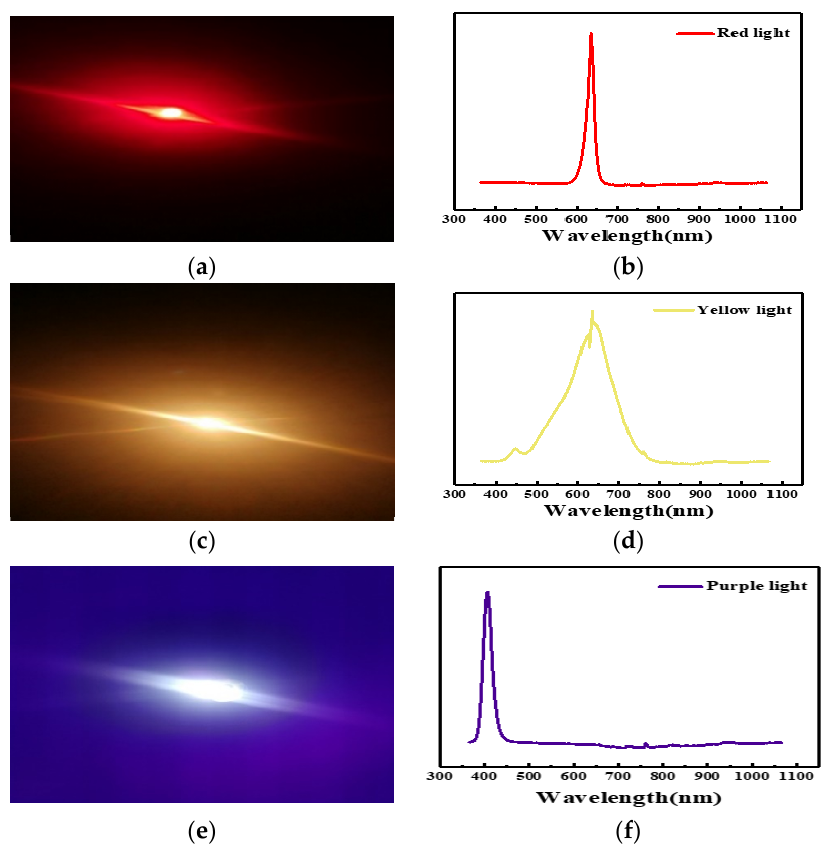
Figure 10. The images of different colors of lights and its wavelength distributions: ( a , b ) Red light, ( c , d ) Yellow light, ( e , f ) Purple light.